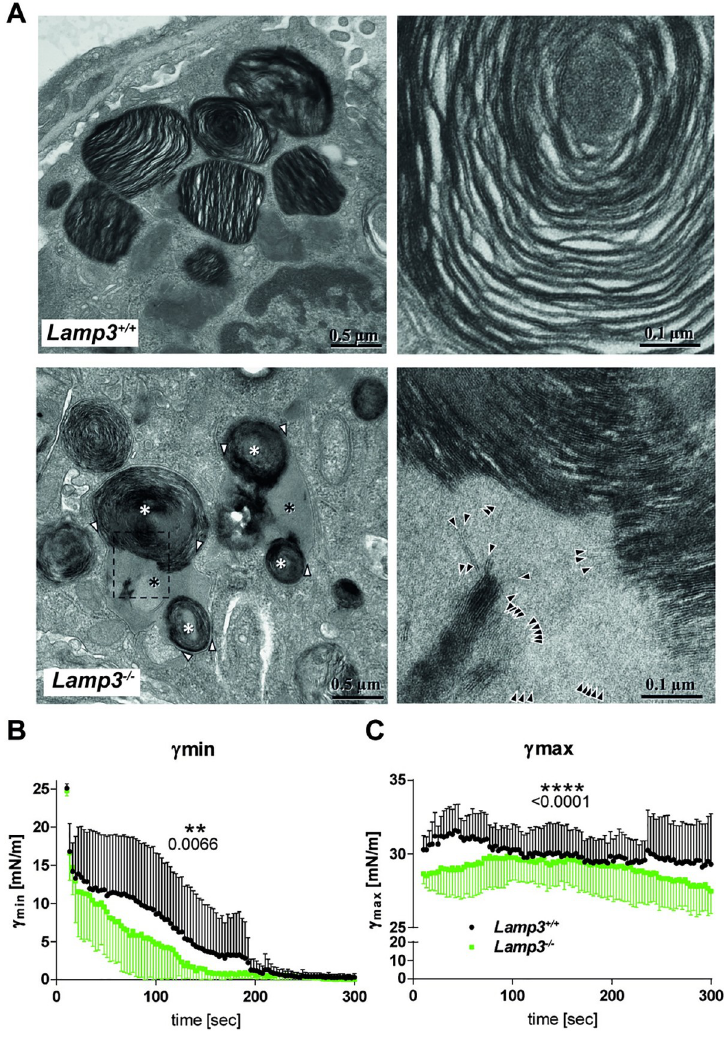
Fig 4. Deficiency of LAMP3 leads to altered LB morphology and reduced surfactant functionality. (A) Transmission electron microscopy of LB in an alveolar AT2 cells of a wildtype and a Lamp3 -/- mouse. Wildtype: Individual Lamellar Bodies are clearly discernible and separated (left), containing continuous lipid lamellae (right). Lamp3 -/- : Left: Multiple clews of lipid lamellae (white asterisks) are located within shared limiting membranes (white arrowheads). The space between the clews (black asterisks) is entirely filled with light grey material. Right: enlargement of the boxed area indicated left. Higher magnification reveals lamellae also inside the light grey material, which in some cases obviously are continuations of the darker stained lamellae inside the clew (top) or the stack of lamellae bottom left. (B, C) Surface tension at minimum ( γ min; C )) and maximum ( γ max; B ) bubble size, derived from a pulsating bubble surfactometer [34] during a pulsating period of 300s. Eight pellets of BAL from Lamp3 -/- and wild type mice were prepared by ultracentrifugation and resuspended in saline CaCl 2 to standardize phospholipids to 1.5 mg/ml each. Phospholipid concentration was determined using a commercial kit. Data are plotted as mean +/-SD. Statistical analysis was performed using an unpaired